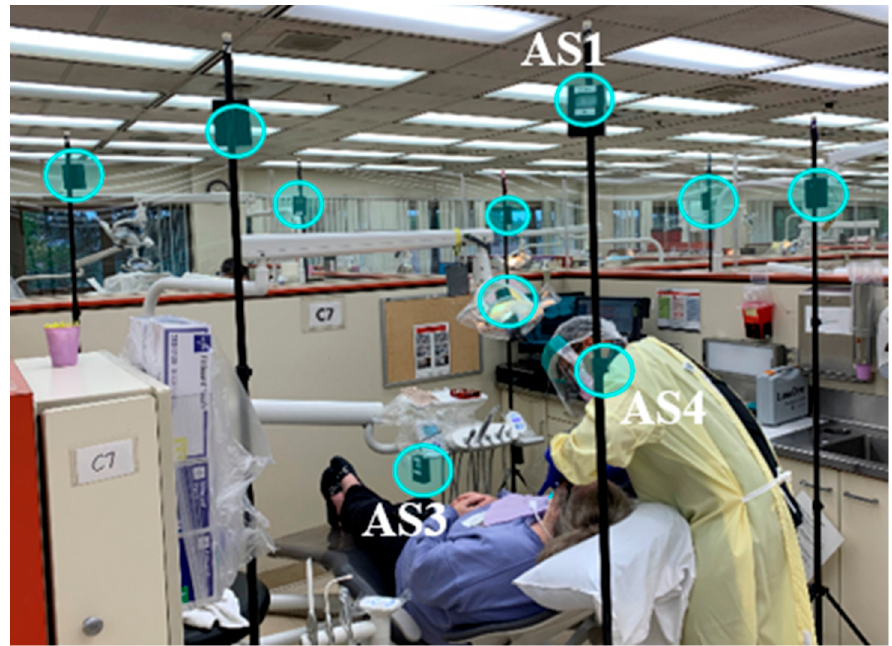
Figure 5. Photograph of the dental facility with 14 sensors (some sensors not in the field of camera view) to monitor dentists’ and patients’ exposure during drilling, composite removal, and cleaning operations. Sensors were placed around the operatory, as well as the surrounding bays, at two different heights.